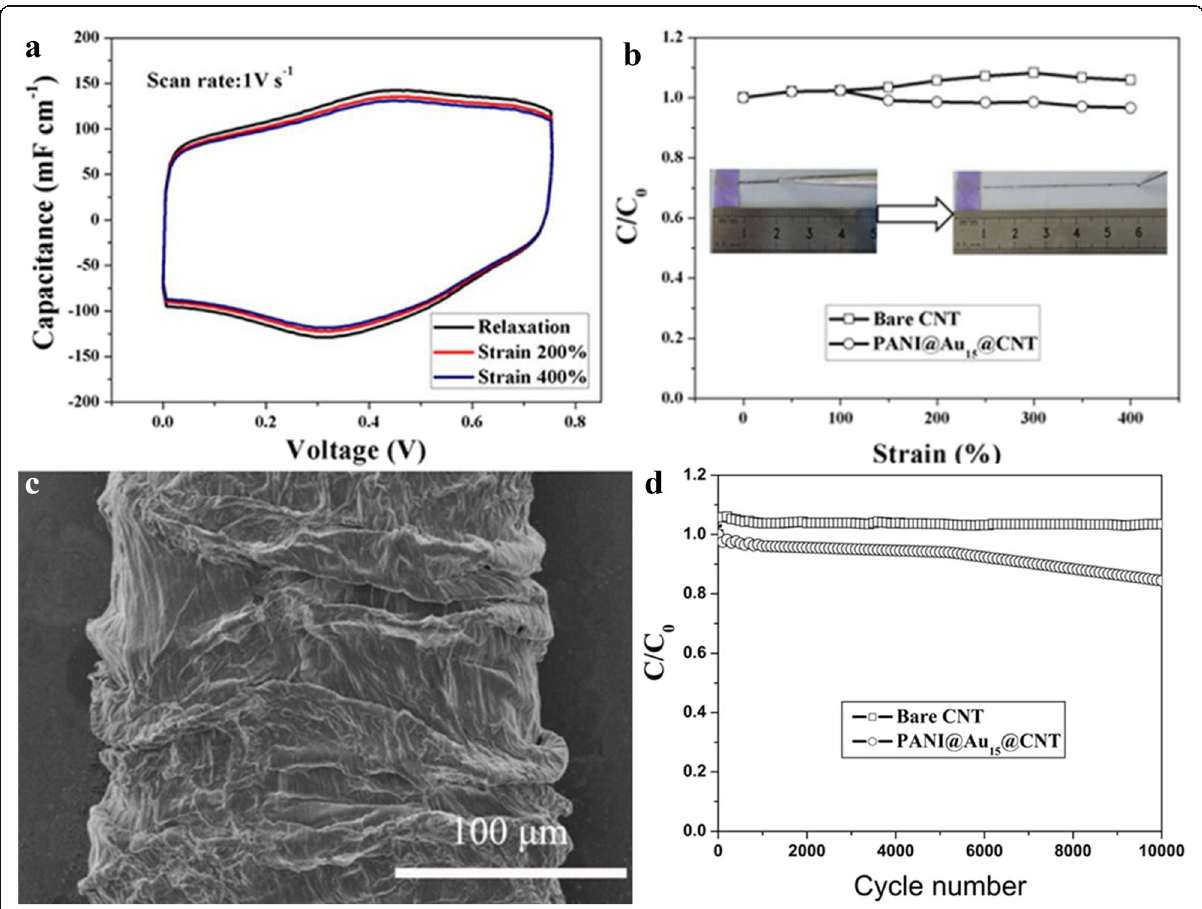
Fig. 5 a CV curves measured at different states. b The normalized capacitance as a function of the tensile strain. c SEM image of stretchable electrode at release state. d The capacitance for the device based on the bare CNT and PANI@Au 15 @CNT